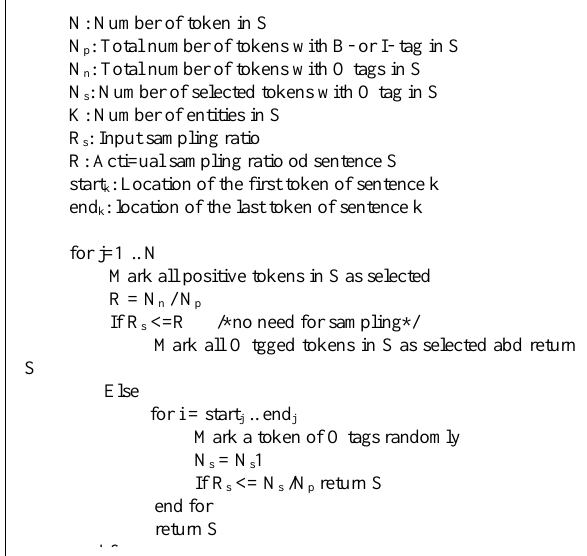
Figure 1: Random under-sampling algorithm used on each